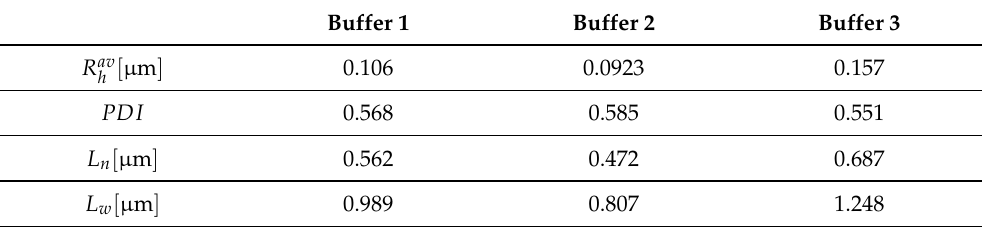
Table 8. Other hydrodynamic properties of single actin filaments obtained with three digits of precision using the optimized parameters presented in Table